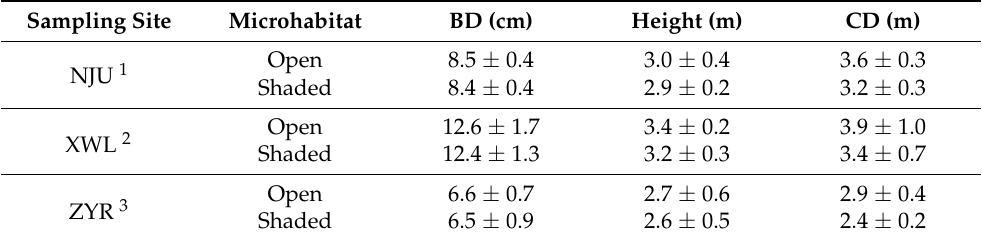
Figure 1. The locations of three sampling sites and 30 selected Acer palmatum trees in the downtown area of Nanjing, eastern China. Dash-circled areas in green, yellow and blue respectively represent Gulou Campus of Nanjing University, Xuanwu Lake Scenic Area and Zhongyang Road. Points in red and black respectively denote selected trees in open and shaded microhabitats. Table 1. Basic information, i.e., mean 1 SD of the basal diameter (BD), height and crown diameter (CD) of selected Acer palmatum trees in three sampling sites.